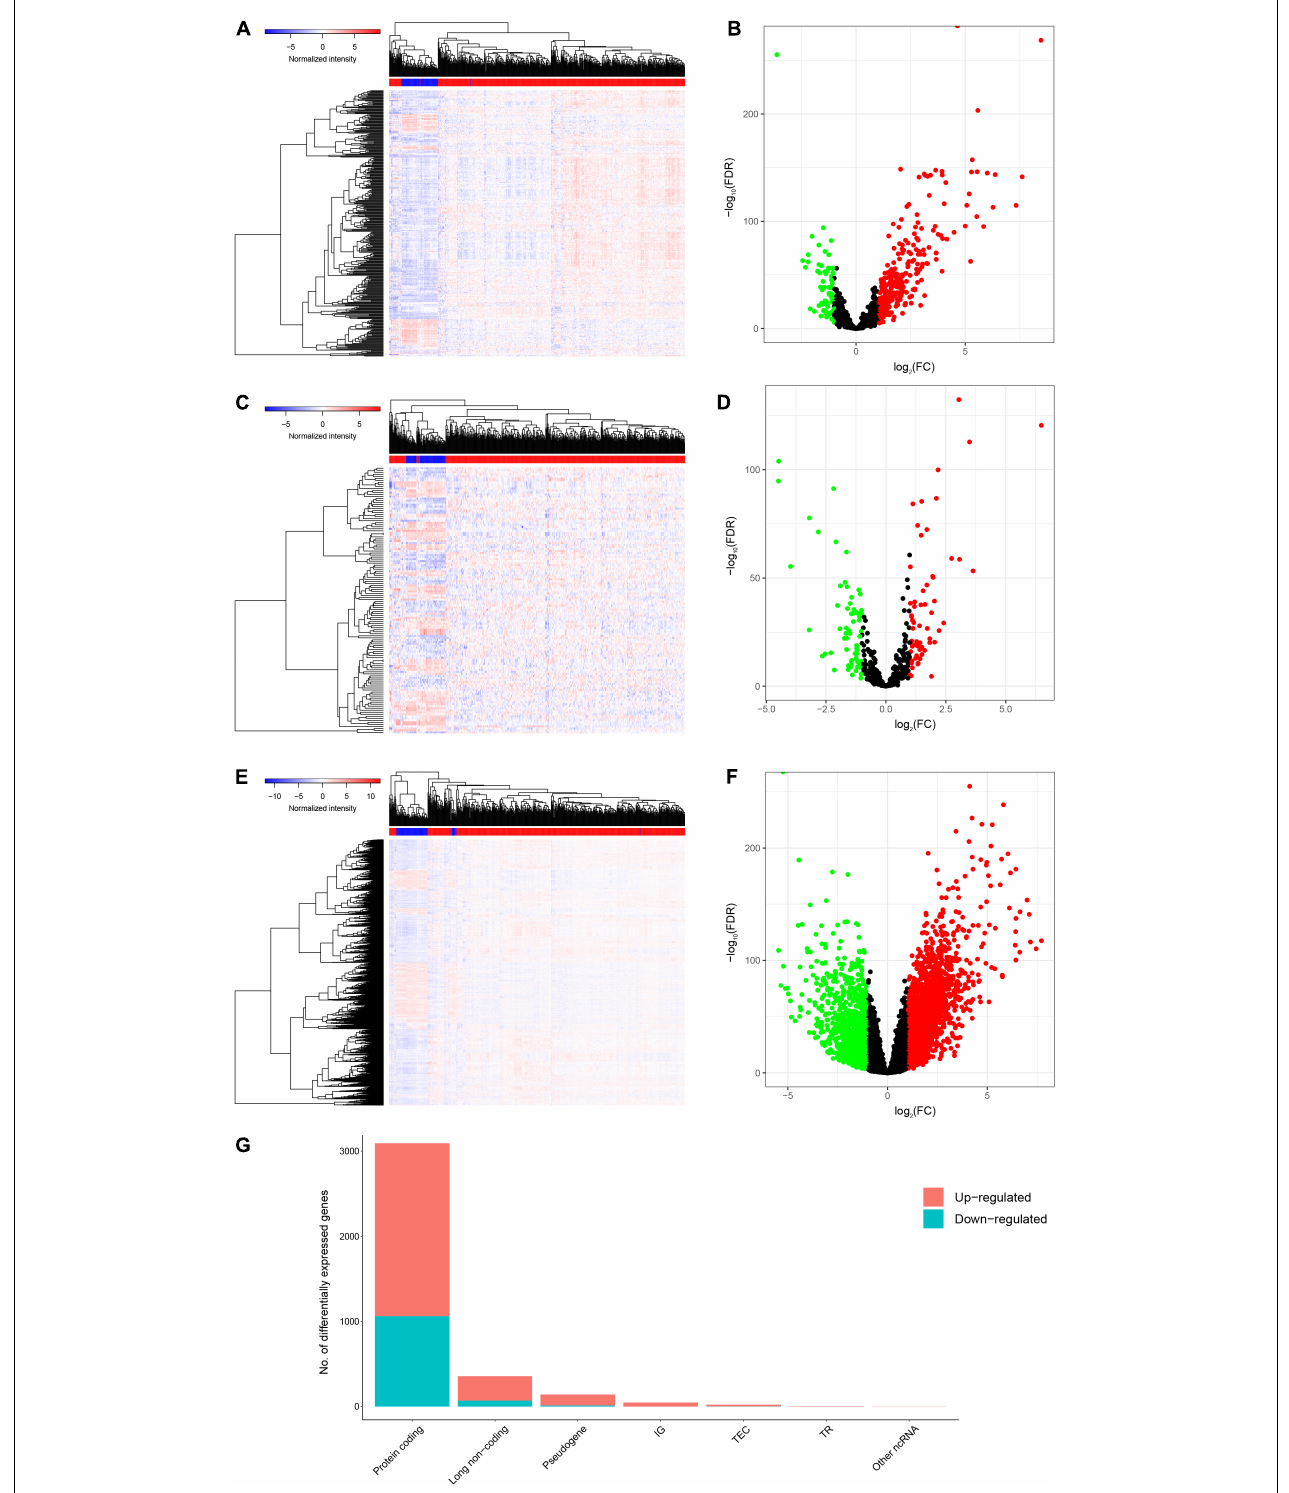
FIGURE 2 | Genes differentially expressed in 506 KIRC tissues versus 71 normal adjacent tissues. Provided are the heatmap (A) and the volcano plot (B) of 357 differentially expressed lncRNAs between the two groups; the heatmap (C) and the volcano plot (D) of 132 differentially expressed miRNAs between the two groups; and the heatmap (E) and the volcano plot (F) of 3092 differentially expressed protein-coding genes between the two groups; and the composition of differentially expressed genes (G) . All differentially expressed genes had a log (fold-change) > 1.0 or < − 1.0 and the overall of FDR < 0.05.